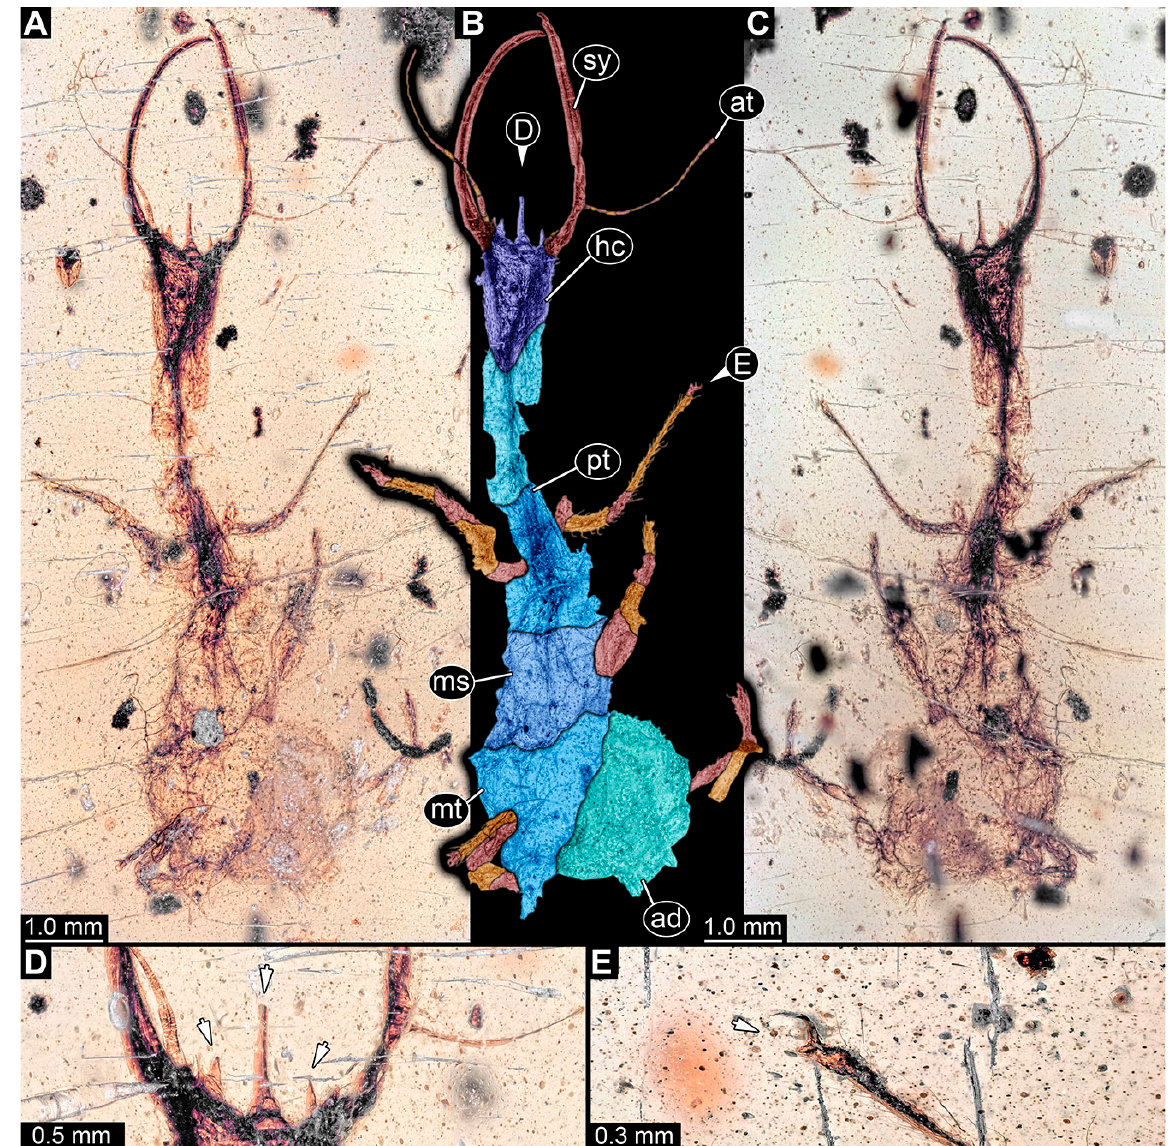
Figure 4. Specimen 57 (PED 0382); Myanmar amber. ( A ) Dorsal view. ( B ) Dorsal view, colour- marked. ( C ) Ventral view. ( D ) Close-up of labrum in dorsal view; arrows mark spine-like protrusions. ( E ) Close-up of first locomotory appendage; arrow marks empodium. Abbreviations: ad = abdomen; at = antenna; hc = head capsule; ms = mesothorax; mt = metathorax; pt = prothorax; sy =